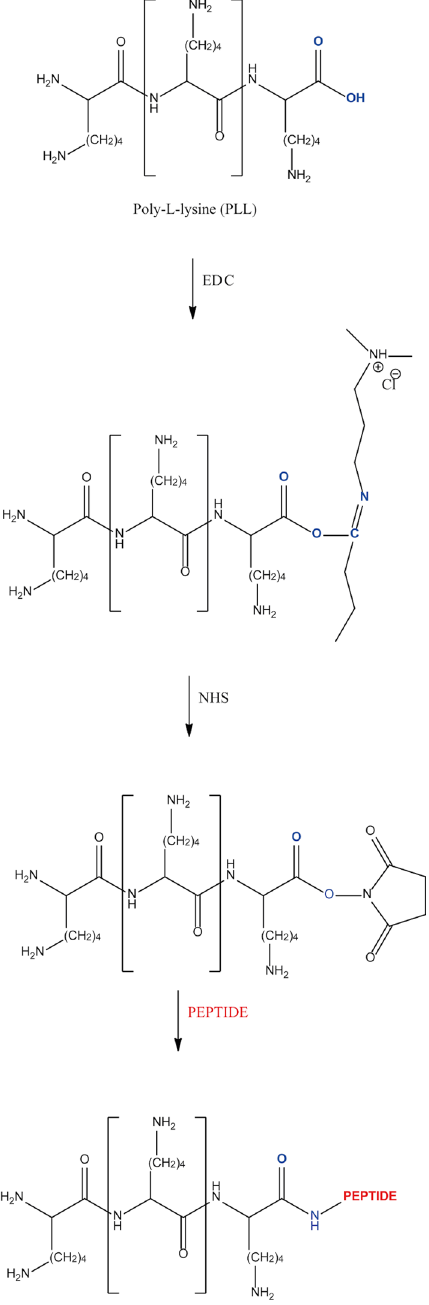
Figure 2. Linker (poly-l-lysine) is bound to a peptide through a EDC/NHS carbodiimide coupling reaction. Active ester was created from a carboxyl group of PLL. Primary amine group of selected peptide reacts and covalently binds to reactive